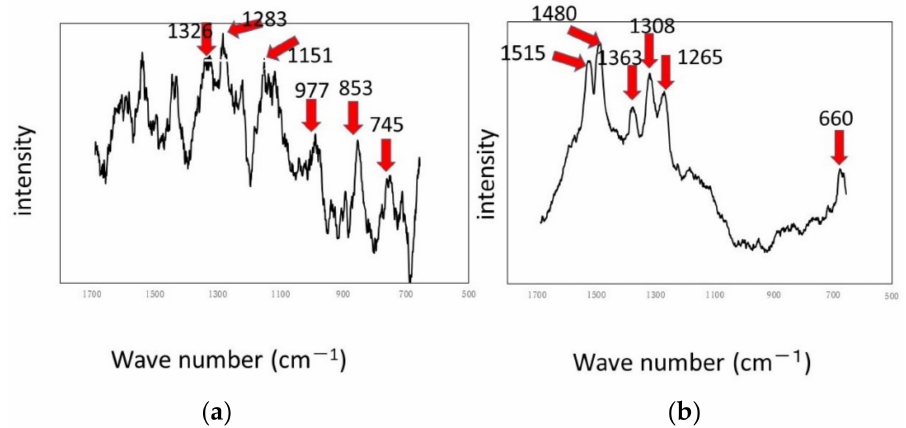
Figure 9. Raman shifts by the RPDLBR: ( a ) titanium specimen and ( b ) aluminum